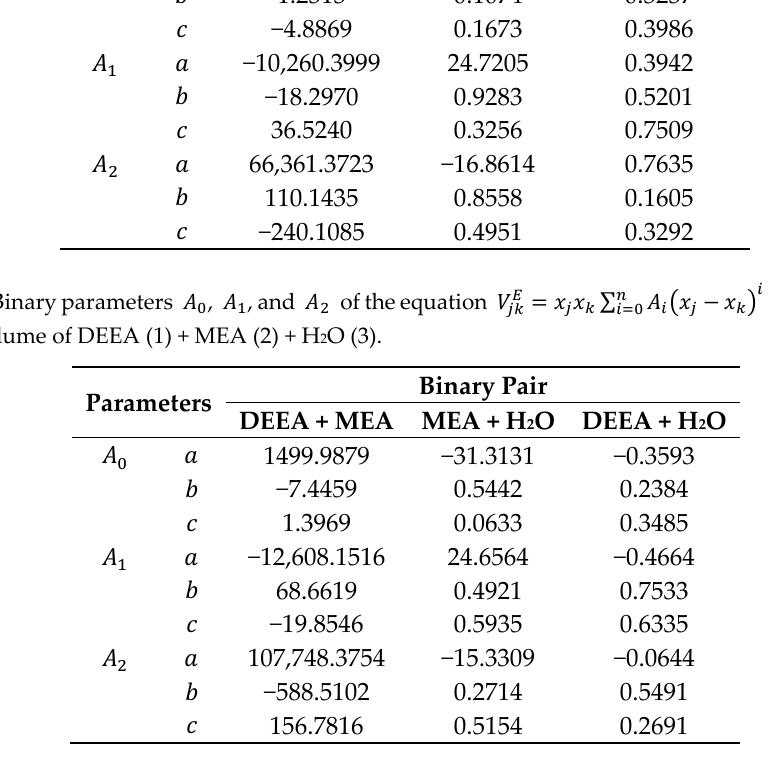
Table 9. Average absolute relative ( AARD ) and absolute maximum ( AMD ) deviations calculated based on the correlation proposed from Equations